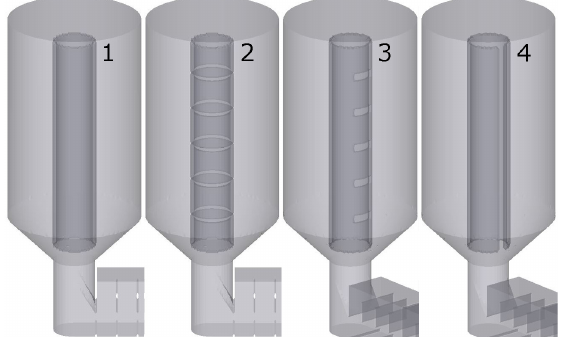
Figure 11. Pipe geometries implemented into the hoppers